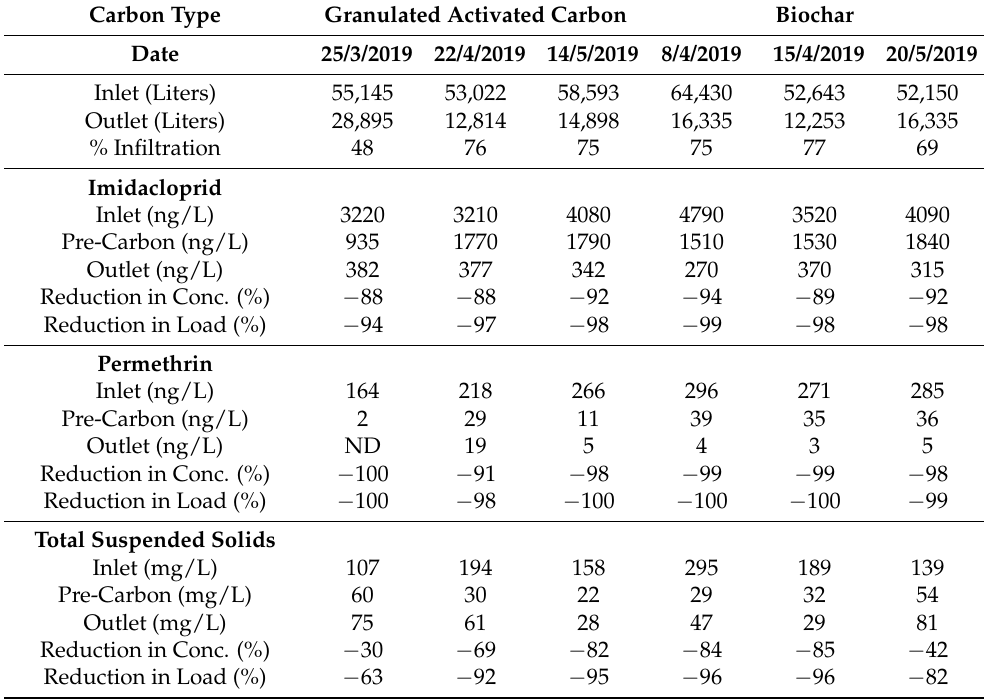
Table 1. Inflow and outflow water volumes, insecticide and total suspended solid concentrations, and relative concentration (Conc.) and load reductions. ND indicates